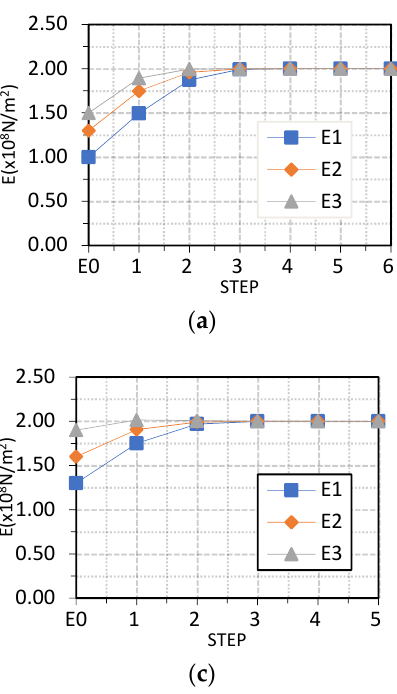
Table 5. Results with different numbers of strain test data ( × 10 8 N/m 2